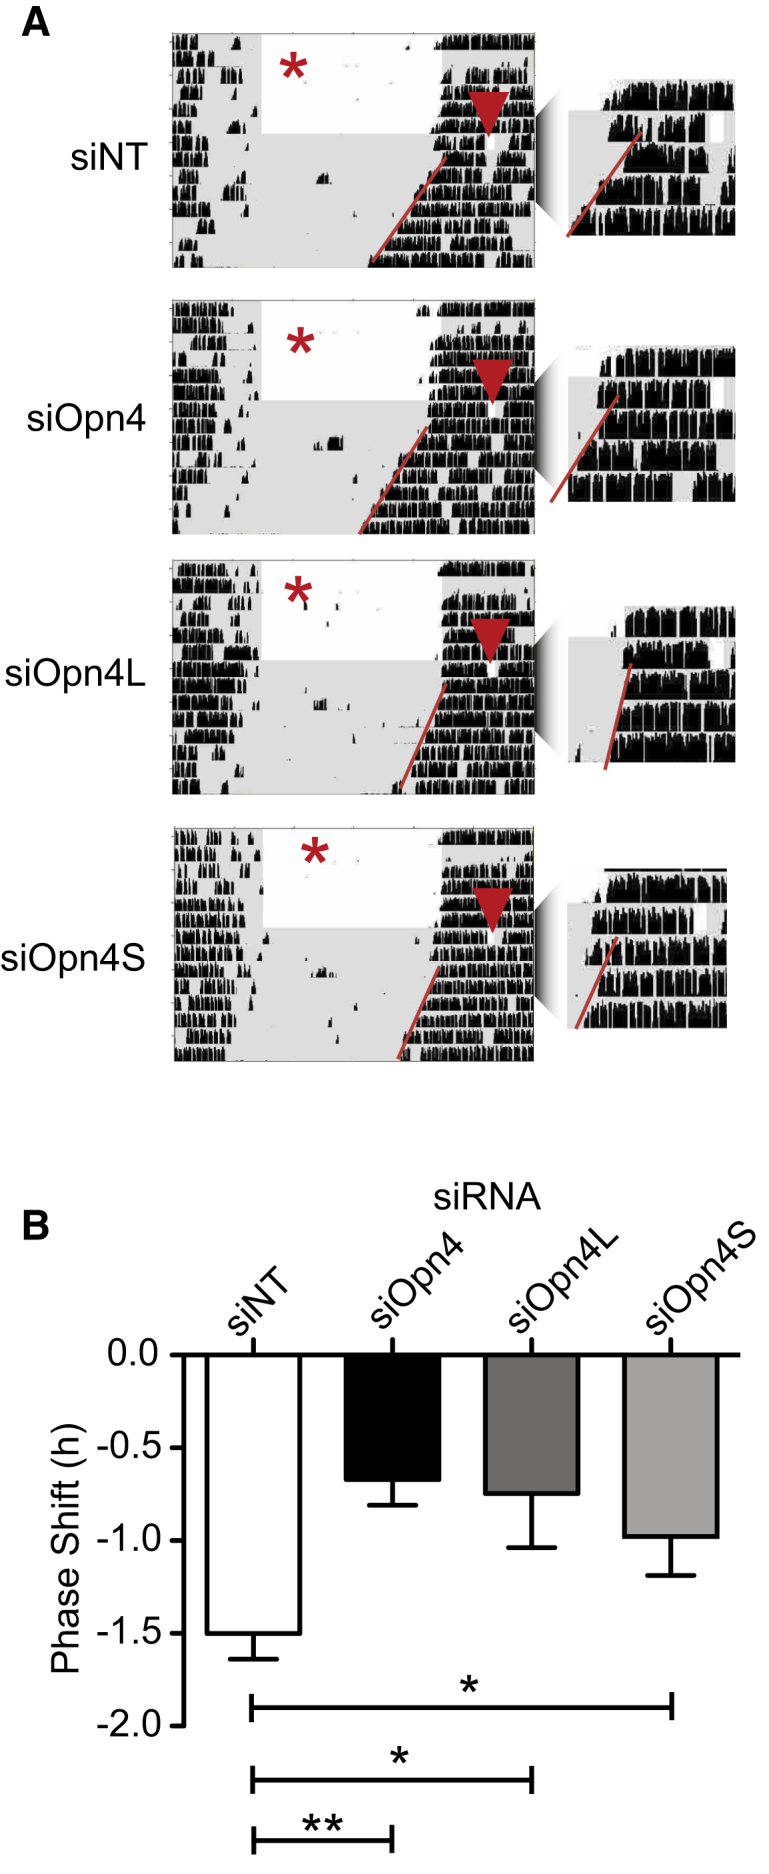
Both Isoforms of OPN4 Mediate Phase Shifting of Circadian Rhythms(A) Representative actograms from animals given intravitreal bilateral injection (indicated by a red star) of siNT, siOpn4, siOpn4S, and siOpn4L. Significantly reduced phase shifting after a 30 min CT16 light pulse (indicated by a red arrow) is seen for all three Opn4-targeting siRNAs versus siNT control. Actograms are enlarged around the light pulse for clarity.(B) Histogram showing average phase shift for siOpn4-treated animals (−0.68 ± 0.13 versus −1.50 ± 0.14 hr; n = 12; p = 0.0003) and siOpn4L and siOpn4S (−0.74 ± 0.29; p = 0.01; n = 8 and −0.98 ± 0.21; p = 0.04; n = 8, respectively). ∗p < 0.05, ∗∗p < 0.01; one-way ANOVA with Tukey’s post-tests. Error bars represent the SEM.See also Figures S1 and S2.